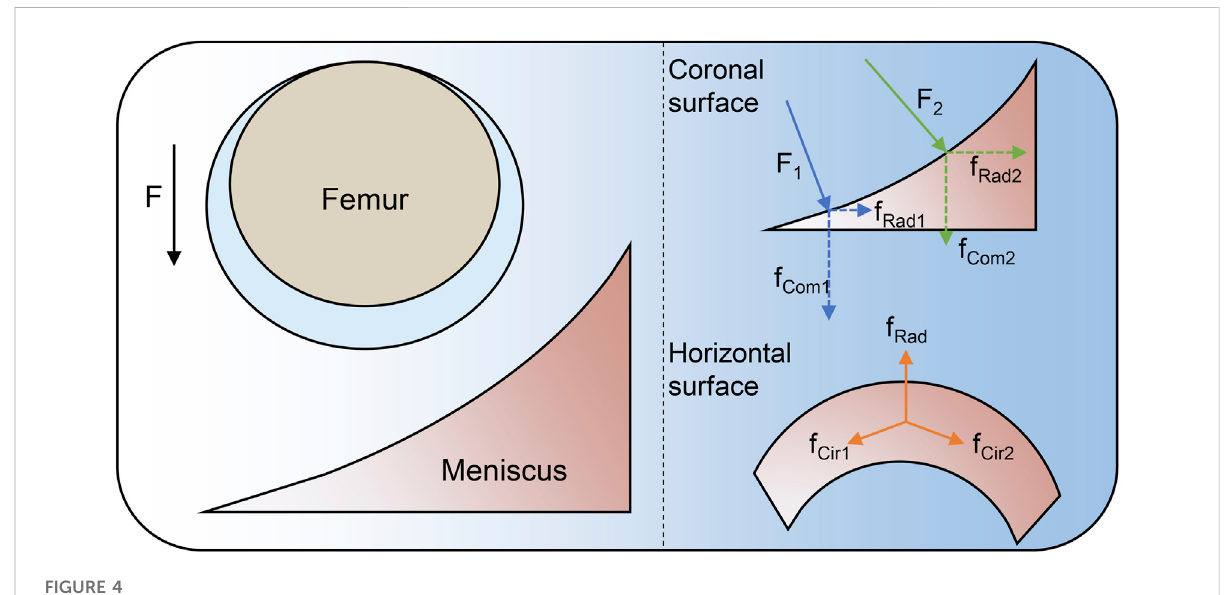
FIGURE 4 Force analysis of